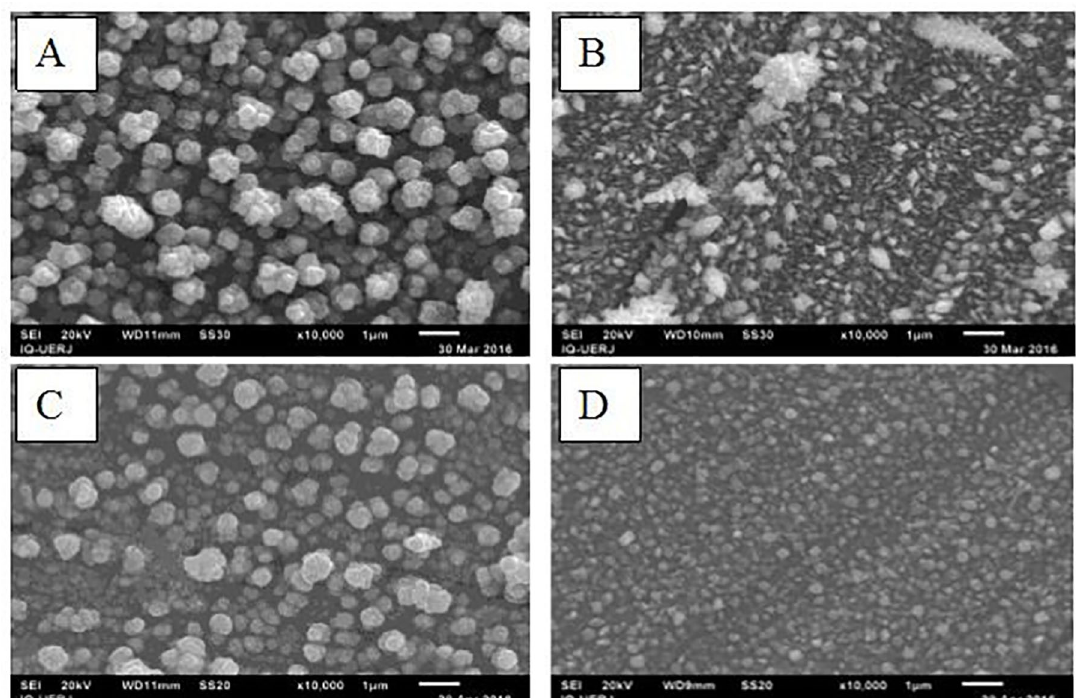
Figure 5. Surface morphology evaluation of the Cu-Co coatings produced at using DC (A, B) and SPC (C, D): (A) Experiment 3, (B) Experiment 4; (C) Experiment 3’; (D) Experiment 4’. Magnification: